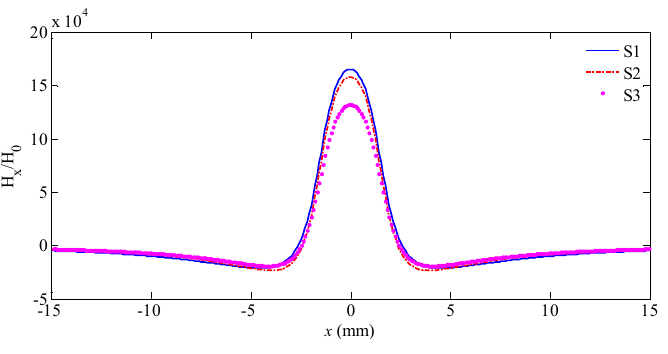
Figure 6. Leakage magnetic fields.